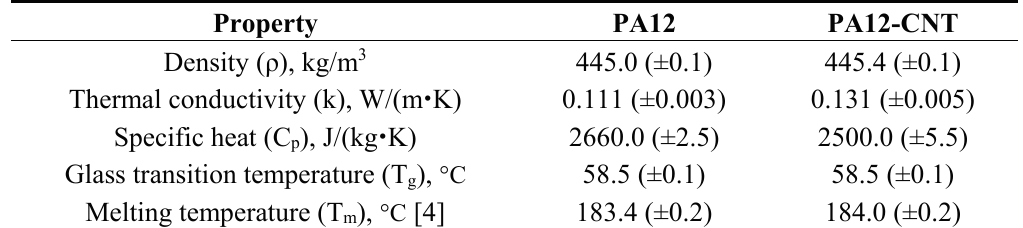
Table 1. Materials properties of PA12 and PA12-CNT used in the